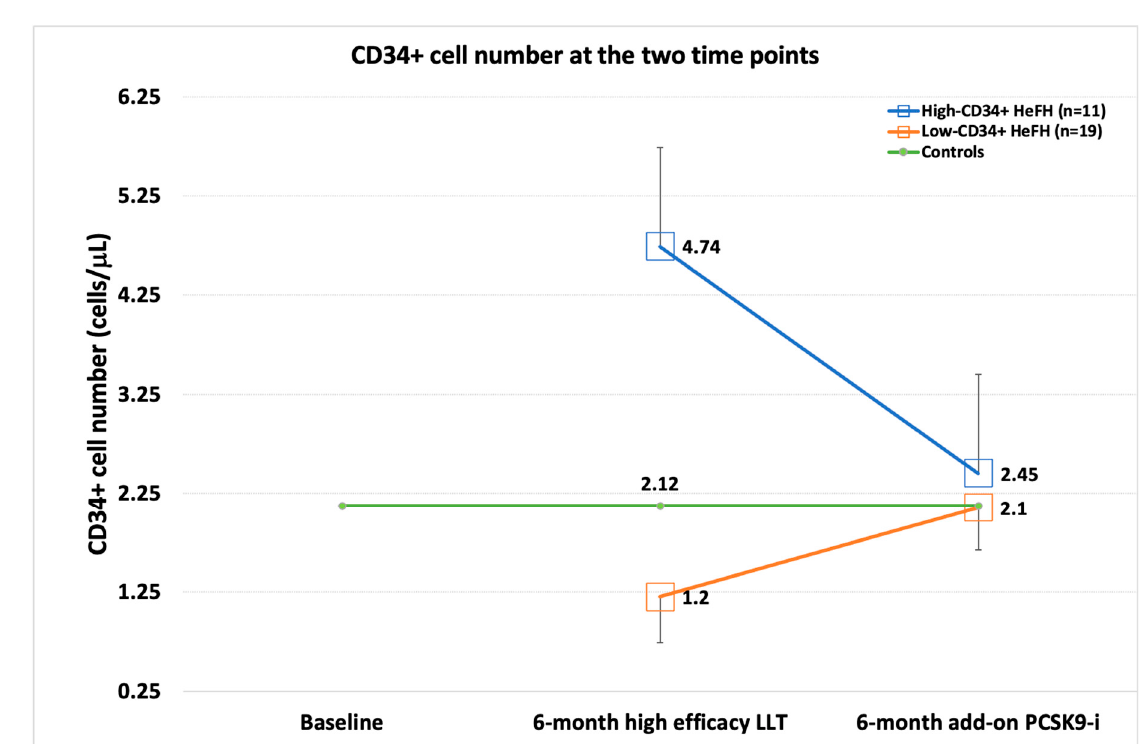
Figure 1. CD34+ cell number at the two scheduled time points in the low-CD34+ cell group and the high-CD34+ cell group; IQR is represented by error bars. Green line represents the median value of baseline CD34+ cells in controls.